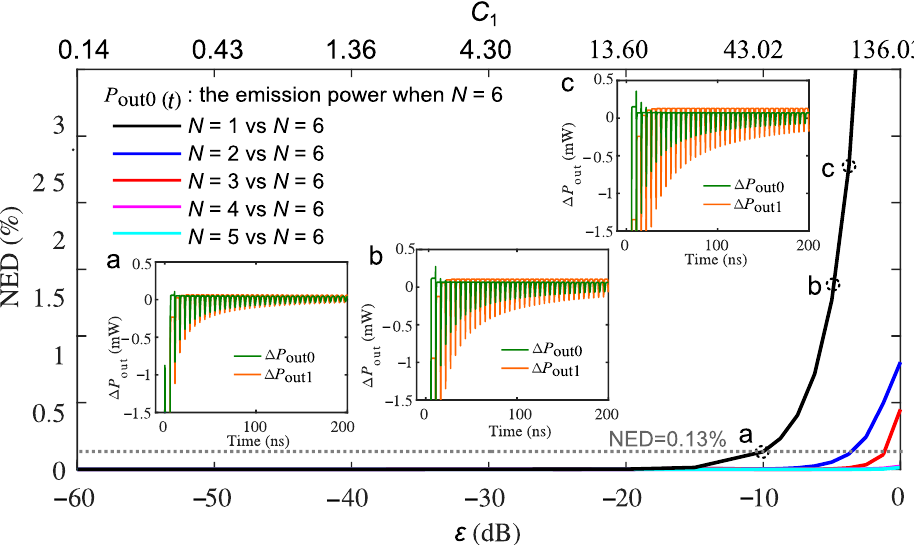
Figure 6. NED between the emission power with varying N and the emission power reference when N = 6 as a function of reinjection coupling factor ε and the feedback parameter C 1 . The AC component of the self-pulsation waveform of the reference emission power ( ∆ P out0 ) and that with N equals to 1 ( ∆ P out1 ) at Point a ( ε = − 10 dB, C 1 = 43.02), b ( ε = − 5 dB, C 1 = 76.50), and c ( ε = − 3.75 dB, C 1 = 88.34) along the black curve (when N = 1) are chosen and shown with green and orange curves in inset a, b, and c, respectively. The dashed grey line indicates the threshold of NED = 1.3% to involve more than one ECRT in the RRE